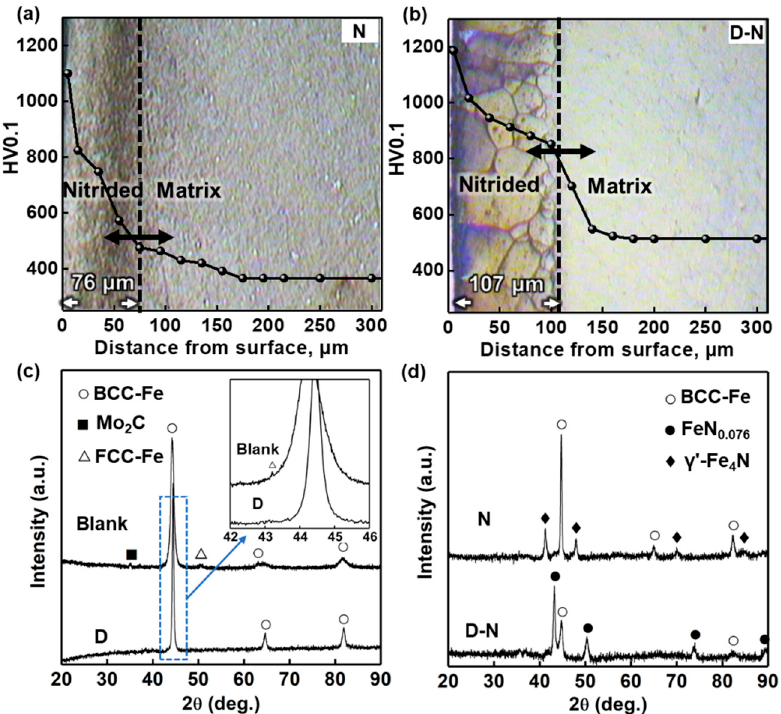
Figure 4. ( a ) Optical micrograph of cross-sectional microstructure of M50 Sample N nitrided at 500 °C for 4 h; ( b ) Optical micrograph of cross-sectional microstructure of M50 Sample D-N nitrided at 500 °C for 4 h; ( c ) XRD patterns of the surface of M50 Sample ‘Blank’ and Sample D without nitriding; ( d ) XRD patterns of M50 Sample N and Sample D-N nitrided at 500 °C for 4 h.